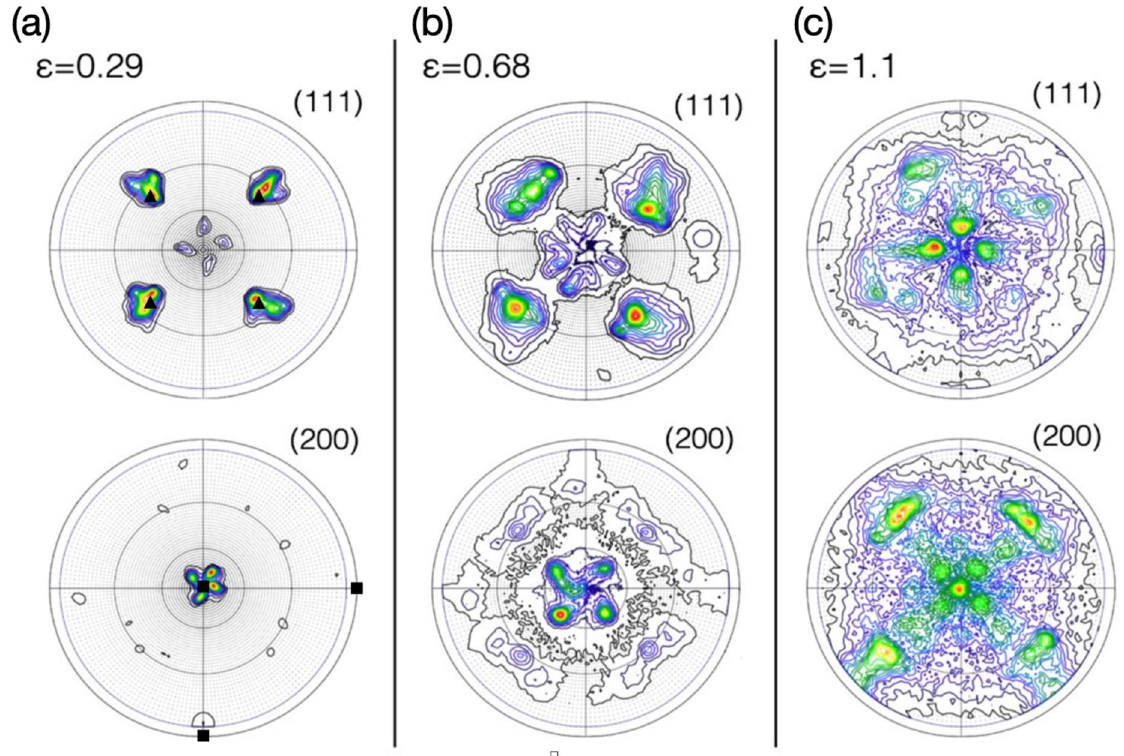
Figure 1. The {111} and {200} pole figures for texture after drawing to cumulative strains of 0.29 ( a ), 0.68 ( b ) and 1.1 ( c ). Initial position of the {111} and {200} poles are marked by the black triangles and squares for the strain of 0.29.